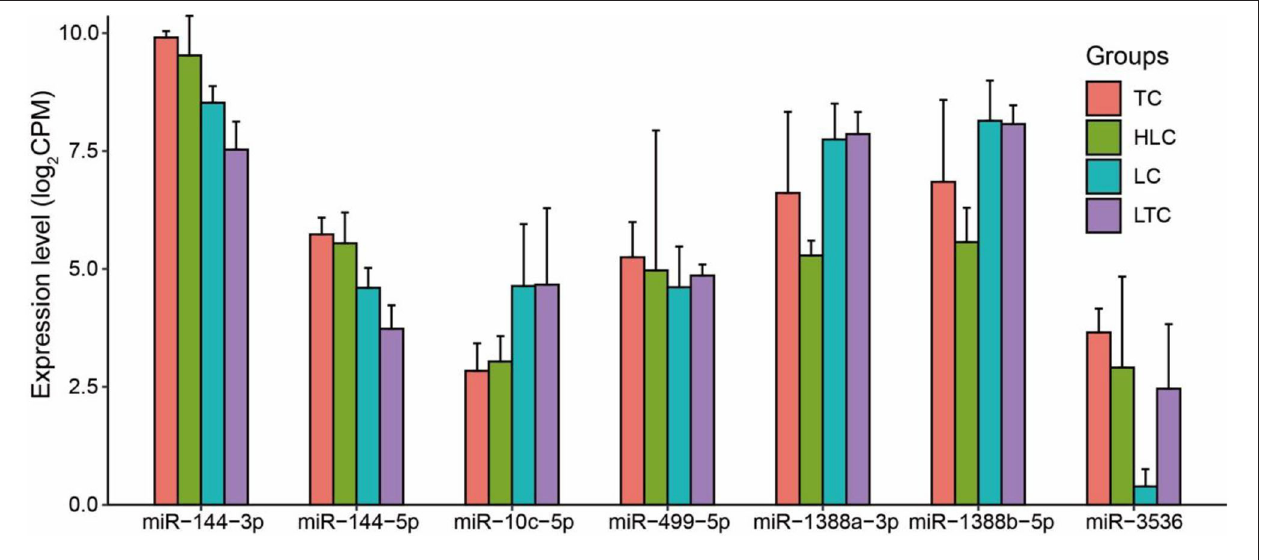
FIGURE 3 | The expression level of candidate